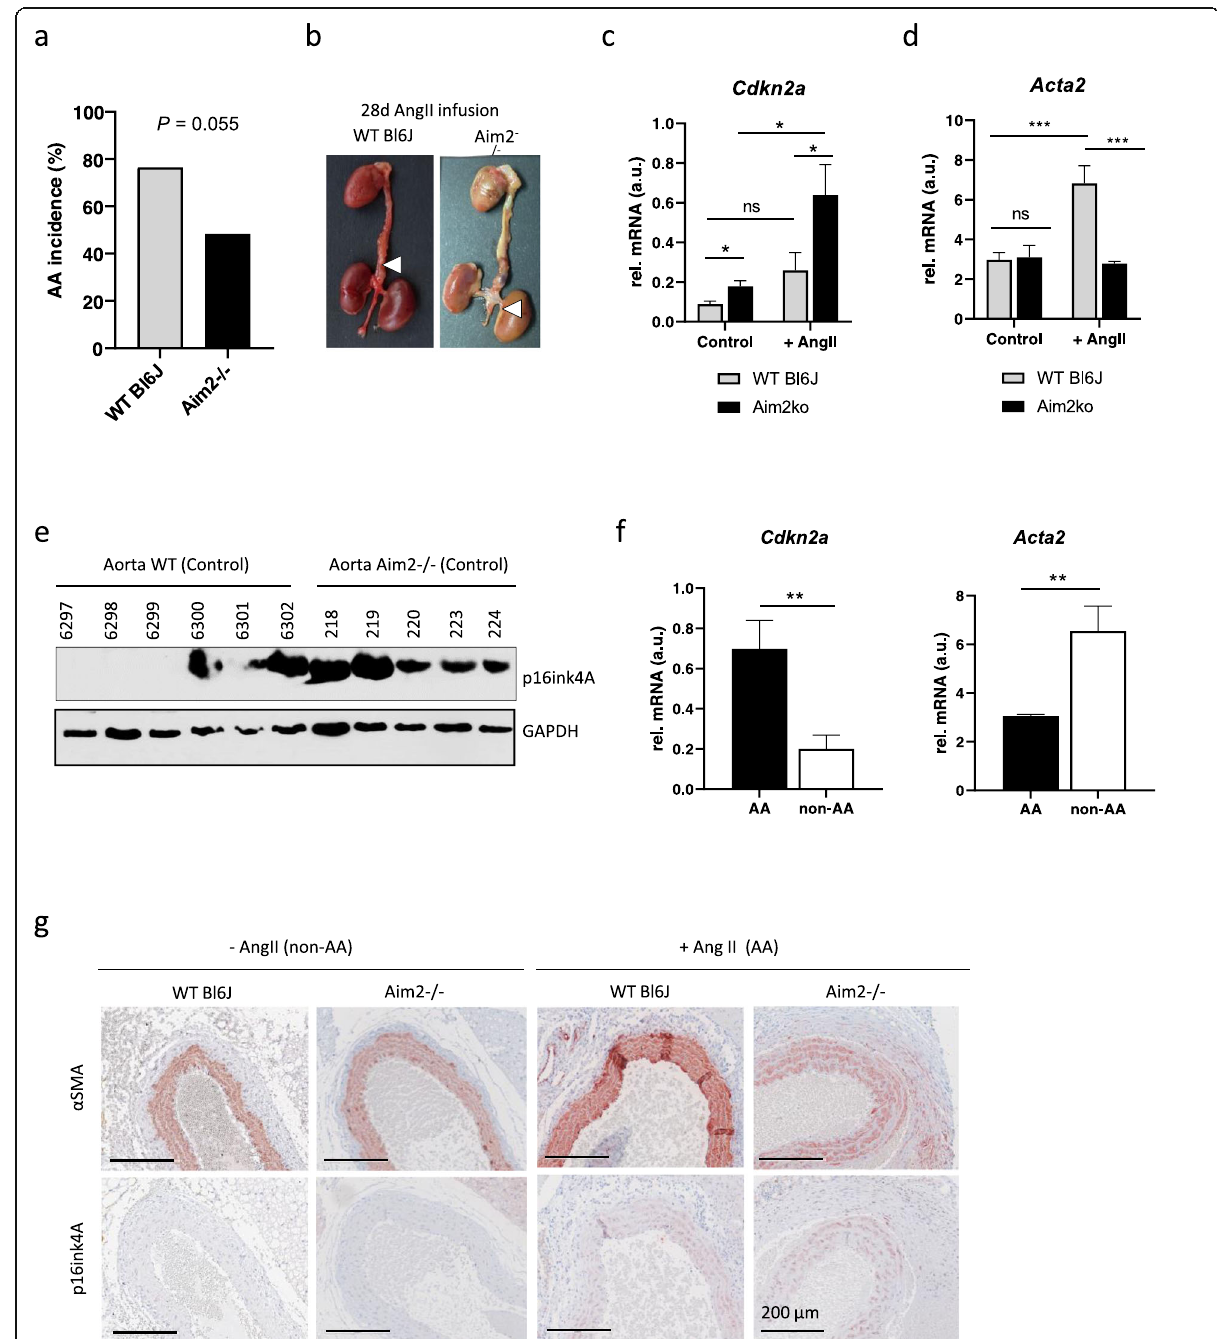
Fig. 4 Involvement of Aim2 deficiency in AA formation. a Quantitative analysis of AA incidence in AngII – infused WT mice ( n = 31) and Aim2 − / − mice ( n = 17). Data were analyzed by one-sided Fisher ’ s exact test. b Representative images of aortas from WT and Aim2 − / − mice infused with 1500 ng/kg/min Ang II for 28 days. c , d Total mRNA was extracted from normal aortas or aortic aneurysms of untreated WT ( n = 6), untreated Aim2 − / − ( n = 7), AngII-infused WT ( n = 3) and AngII-infused Aim2 − / − ( n = 3) mice. c Expression of Cdkn2a mRNA is increased in aortas from Aim2 − / − mice d Acta 2 mRNA is increased in aortas from AngII infused WT mice. e Western blot, demonstrating increased expression of p16ink4A in aortic lysates of untreated Aim2 − / − mice. f Increased mRNA expression of Cdkn2a (p16) and reduced mRNA expression of Acta2 was detected in AA compared with non-AA from AngII infused animals. Bars show the mean ± SEM. c , d , f Data were tested by one-way ANOVA. ns: not significant, *: P < 0.05, **: P < 0.01, ***: P < 0.001. g Aortic sections immunohistochemically stained for α -SMA and